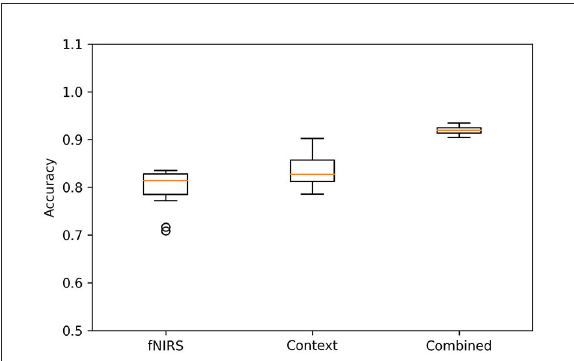
FIGURE4 Accuracies for the three models. The figure shows boxplots for all three models, cross-validation folds, and participants.